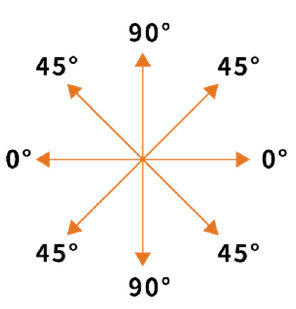
Figure 1. Schematic of octilinear route directions (Wolff, 2007).